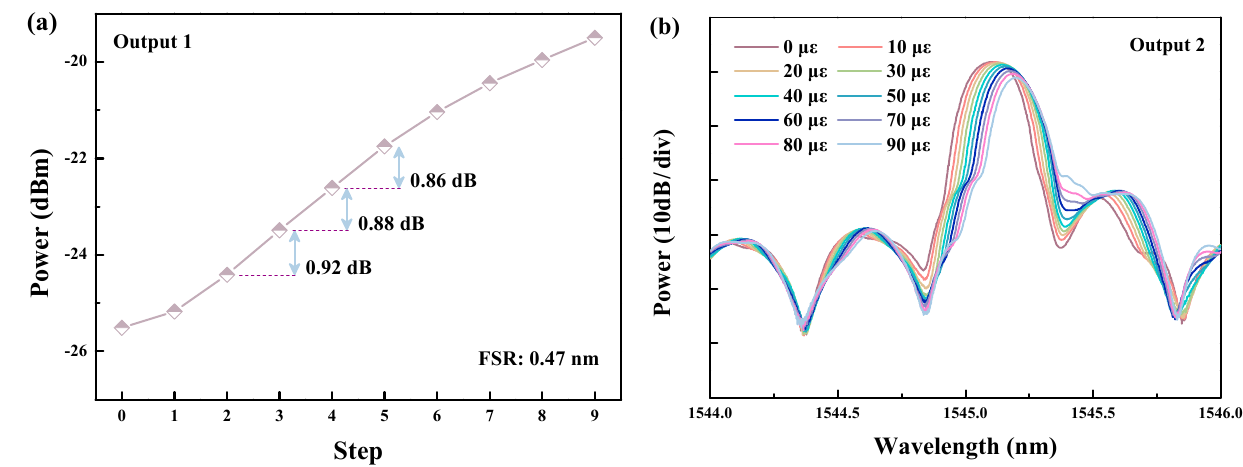
Figure 5. ( a ) Power variation at output 1 of the TDI, where the FBG is subjected to a strain of 10 µε per step, with strains corresponding to 0 µε to 90 µε from step 0 to step 9. ( b ) spectral variation at output 2 of the TDI, where the FBG is subjected to a strain of 10 µε per step, with strains corresponding to 0 µε to 90 µε .